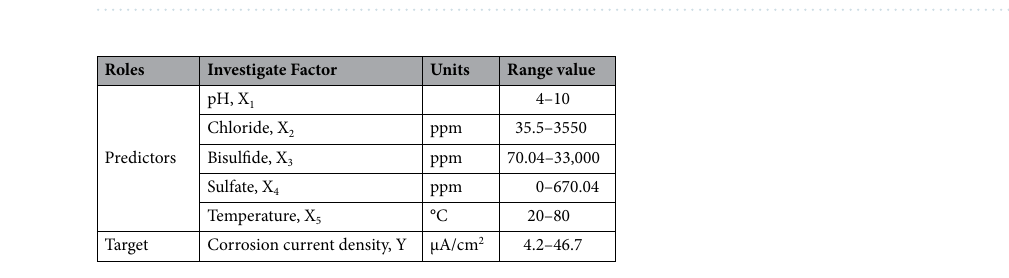
Figure 4. Steps performed on IBM SPSS modelers for the prediction of the external corrosion rate of carbon steel in soil.